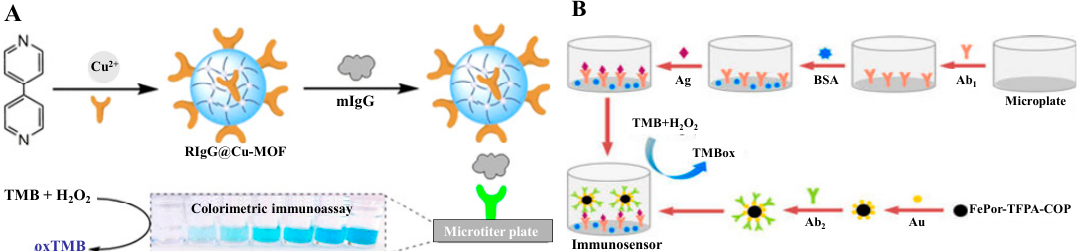
Figure 8. ( A ) Illustration of the colorimetric immunoassay of mIgG based on RIgG@Cu-MOF as a detection antibody. Reproduced with permission from [88]. Copyright American Chemical Society, 2018. ( B ) Illustration of the fabrication of FePor-TFPA-COP-based colorimetric immunoassay. Reproduced with permission from [93]. Copyright American Chemical Society, 2017.